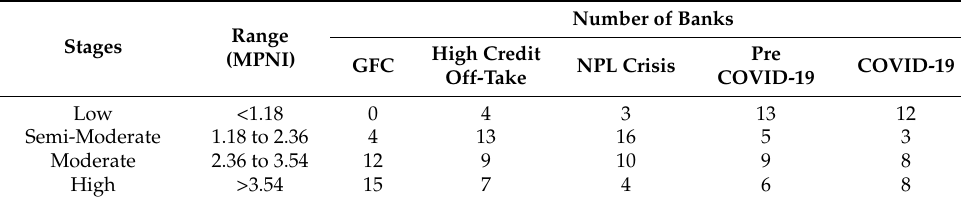
Table 4. Classification for stages of market power along with number of sample banks.